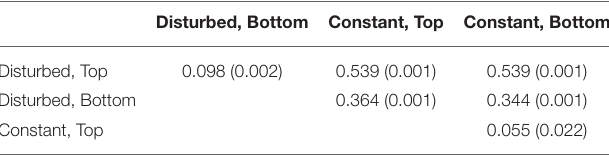
TABLE 2 | ANOSIM R values a and their significance ( p -values in parentheses) comparing all combinations of the ARISA communities of each port of each reactor during Phase